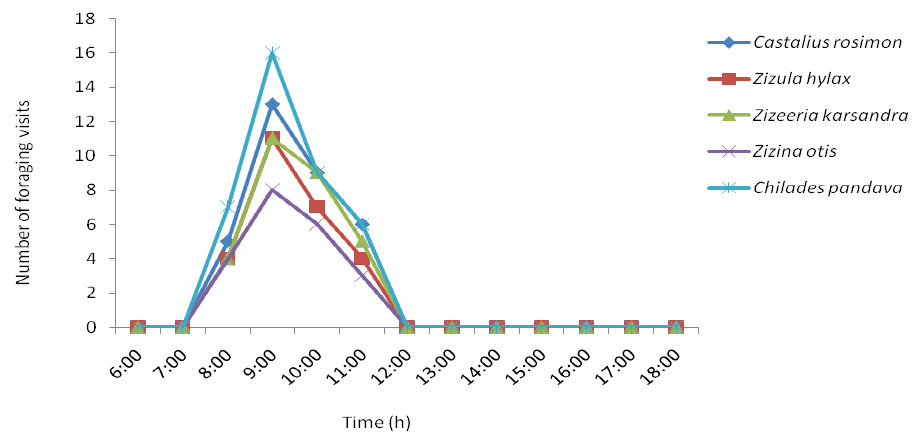
Figure 4. Hourly foraging activity of lycaenid butterflies on Mollugo pentaphylla